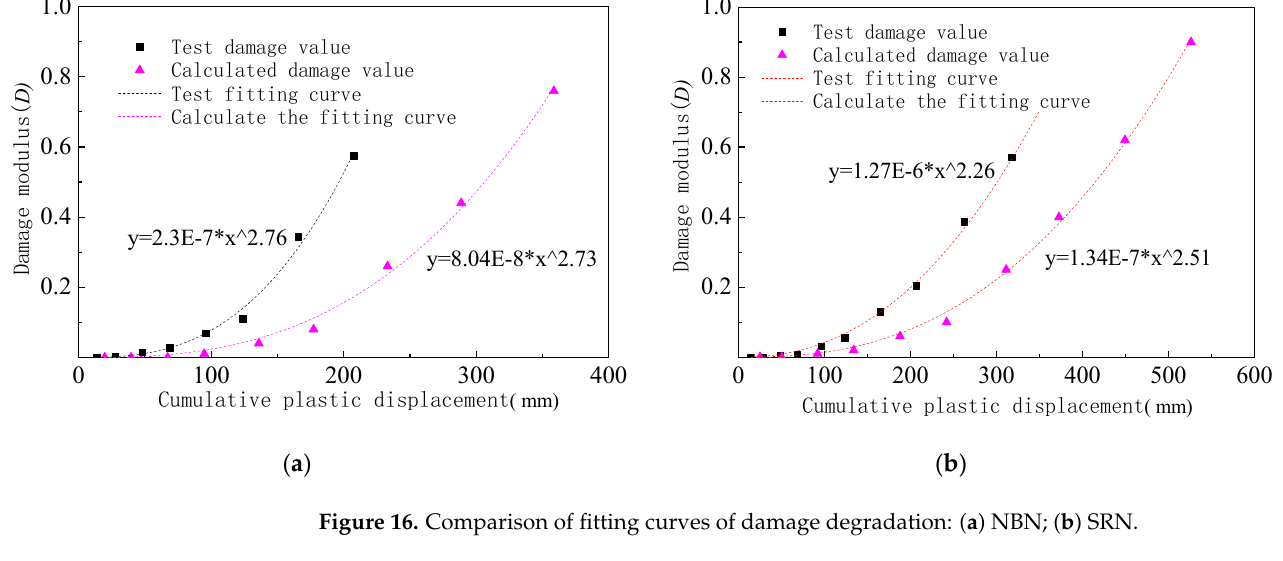
Figure 16. Comparison of fitting curves of damage degradation : (a) NBN ; (b) SRN .